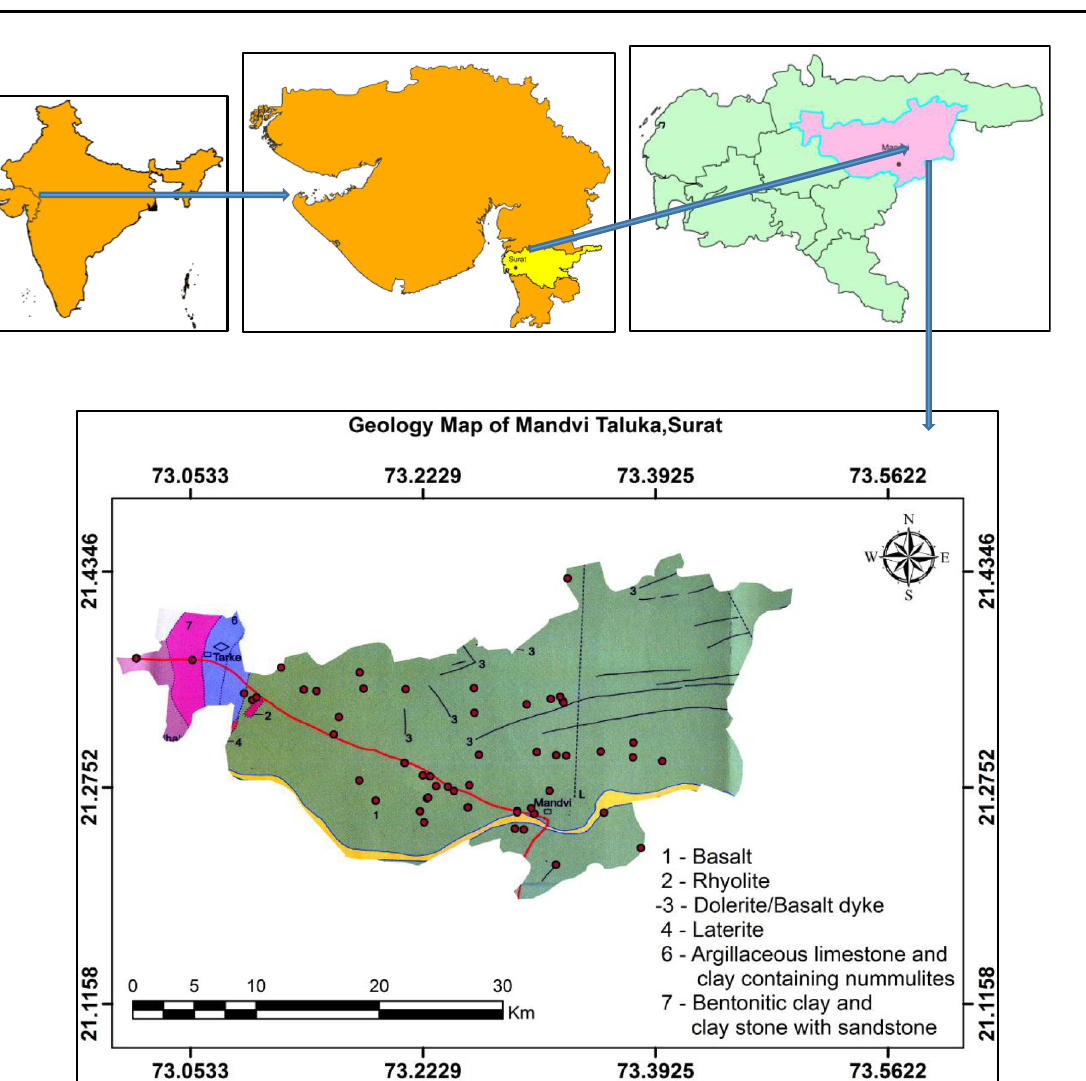
Fig. 1 Sample locations over the geology map of the study area. Source: District Resource Map Surat District, Gujarat,